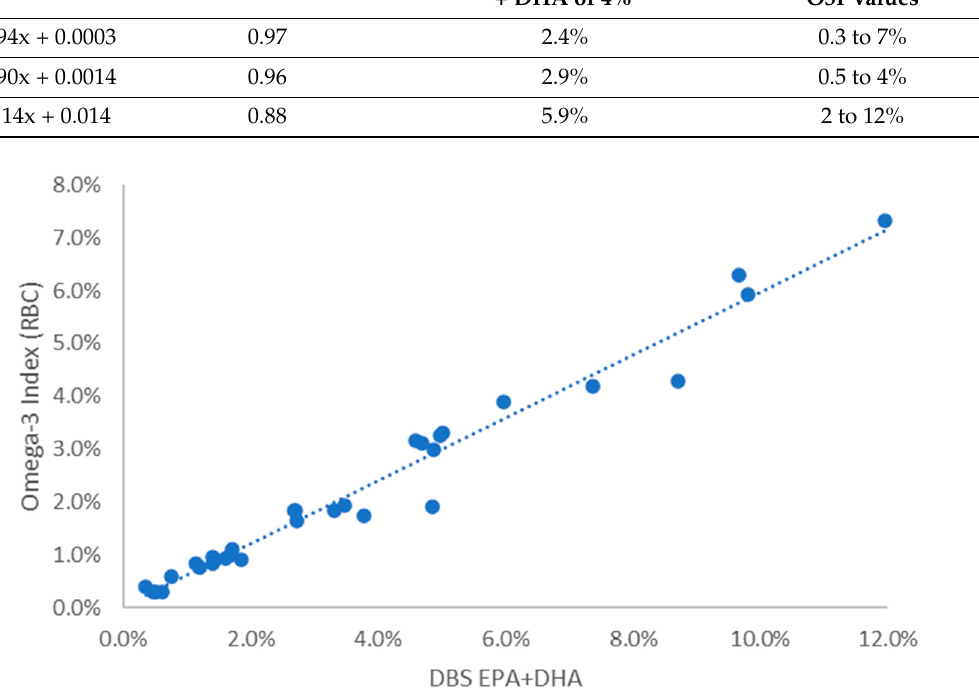
Figure 1. Relationship between the EPA + DHA content of DBS samples and the Omega-3 Index in 33 dogs. DBS, dried blood spot; RBC, red blood cell.